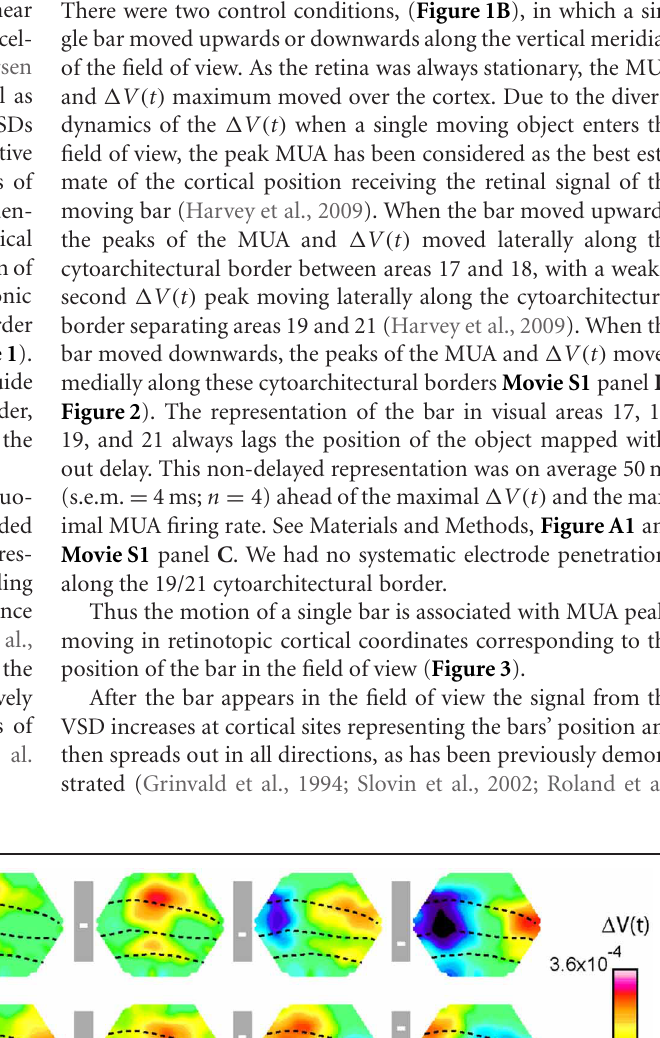
between the representation sites of the two bars at the 19/21 border, this is the slender spatially restricted pre-depolarization, SRP and the beginning of a similar SRP is seen along the 17/18 border (150ms). After 450ms the amplitude of the (cid:3) V ( t ) decreases. Notably, we did not perform specific subtractions of the (cid:3) V ( t ) from bars with other orientations, and consequently no orientation specific domains can be seen in the figures or movies as the orientation specific part of the (cid:3) V ( t ) amounts to maximally 15% (Sharon et al., 2007). Data filtered with a σ = 20 frame temporal filter. The snapshots cannot reveal the full dynamics, for this the reader should look at the Movies S1 – S3